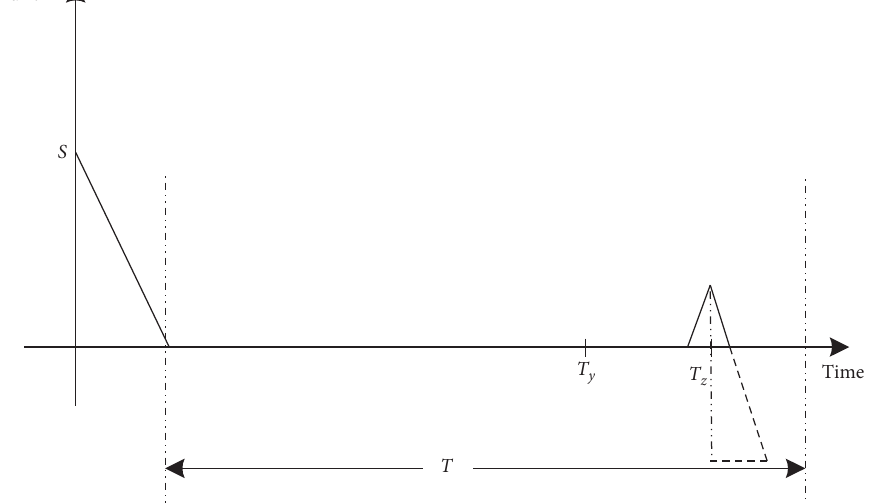
Figure 12: Buffer stock change diagram in a cycle for T > T